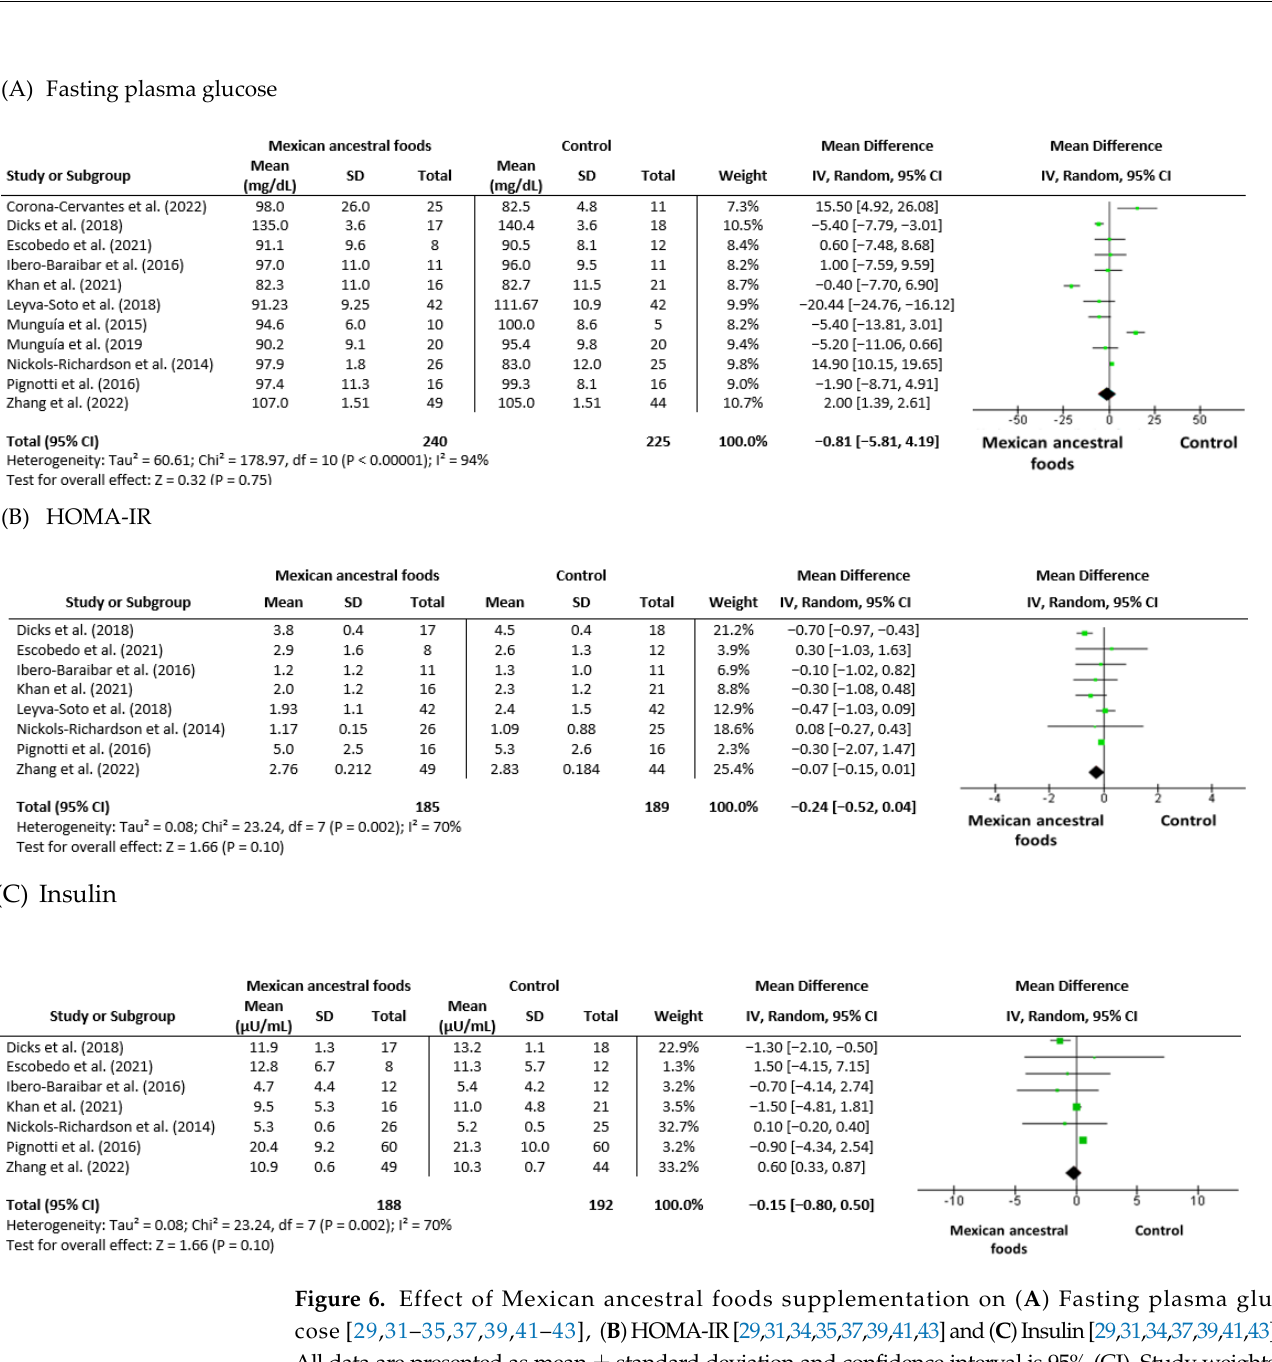
Figure 5. Effect of Mexican ancestral foods supplementation on ( A ) Total cholesterol [29,31 – 35,37,40 – 43] , ( B ) Triglycerides [32 – 35,37,41 – 43] , ( C ) LDL-c [29,32 – 35,37,40 – 43] and ( D ) HDL-c [32 – 35,37,40 – 43] . All data are presented as mean ± standard deviation and confidence interval is 95% (CI). Study weights were assigned using the inverse variance method and random-effects model. The diamond ( ) represents the overall effect estimate of the meta-analysis and the green point ( ) represents mean difference of effect measure of each study.